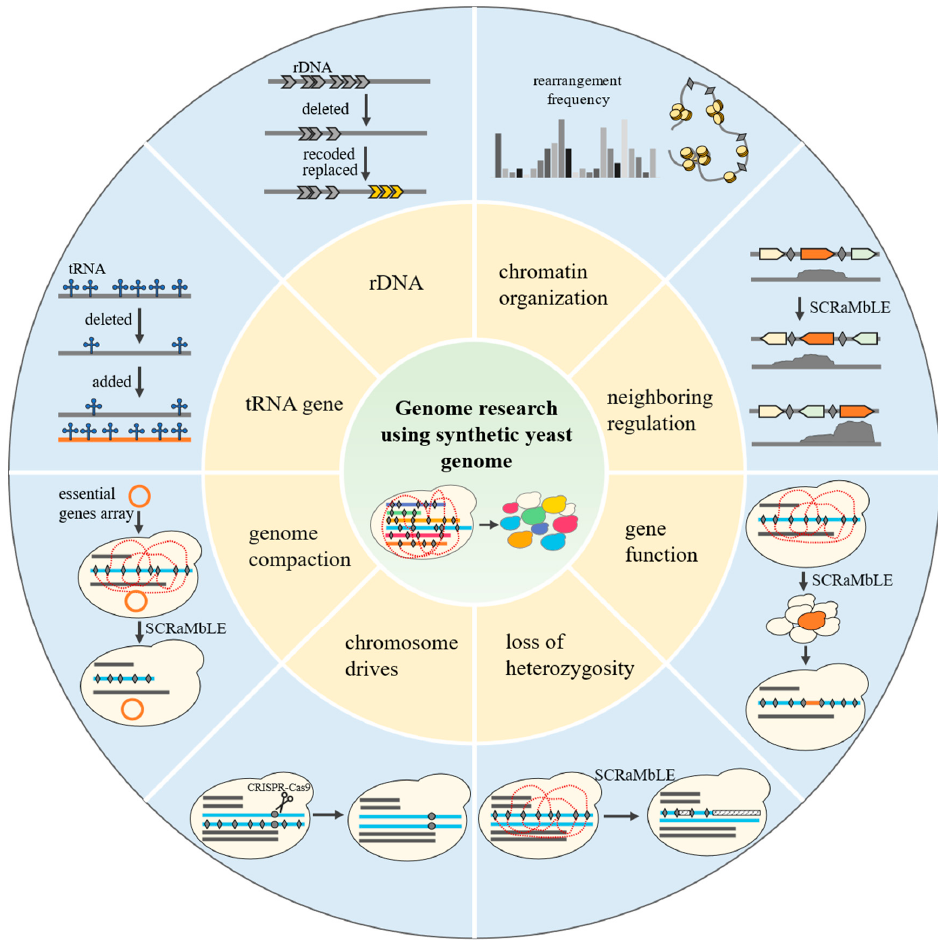
Figure 4. Genome research using a synthetic yeast genome. Synthetic yeast genome replaced tRNA and rDNA to research their function. Structure, function, and evolution of the genome were investigated by SCRaMbLE. Furthermore, the synthetic yeast genome was used to drive chromosomes and compact the